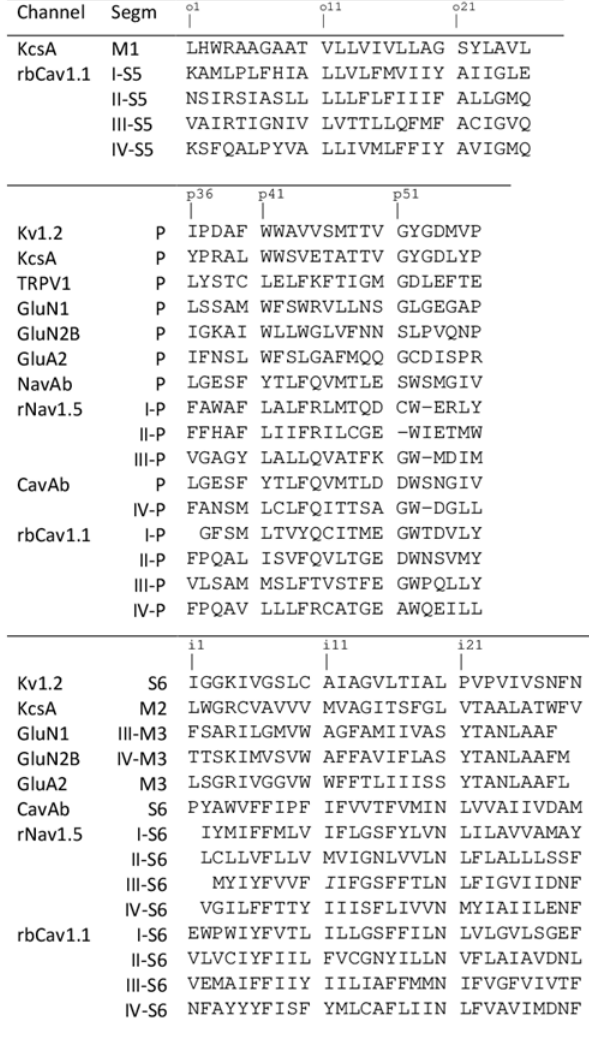
Figure 1. Sequence alignment of helices in the pore domain of P-loop channels. Universal labels of residues are shown above the sequences.